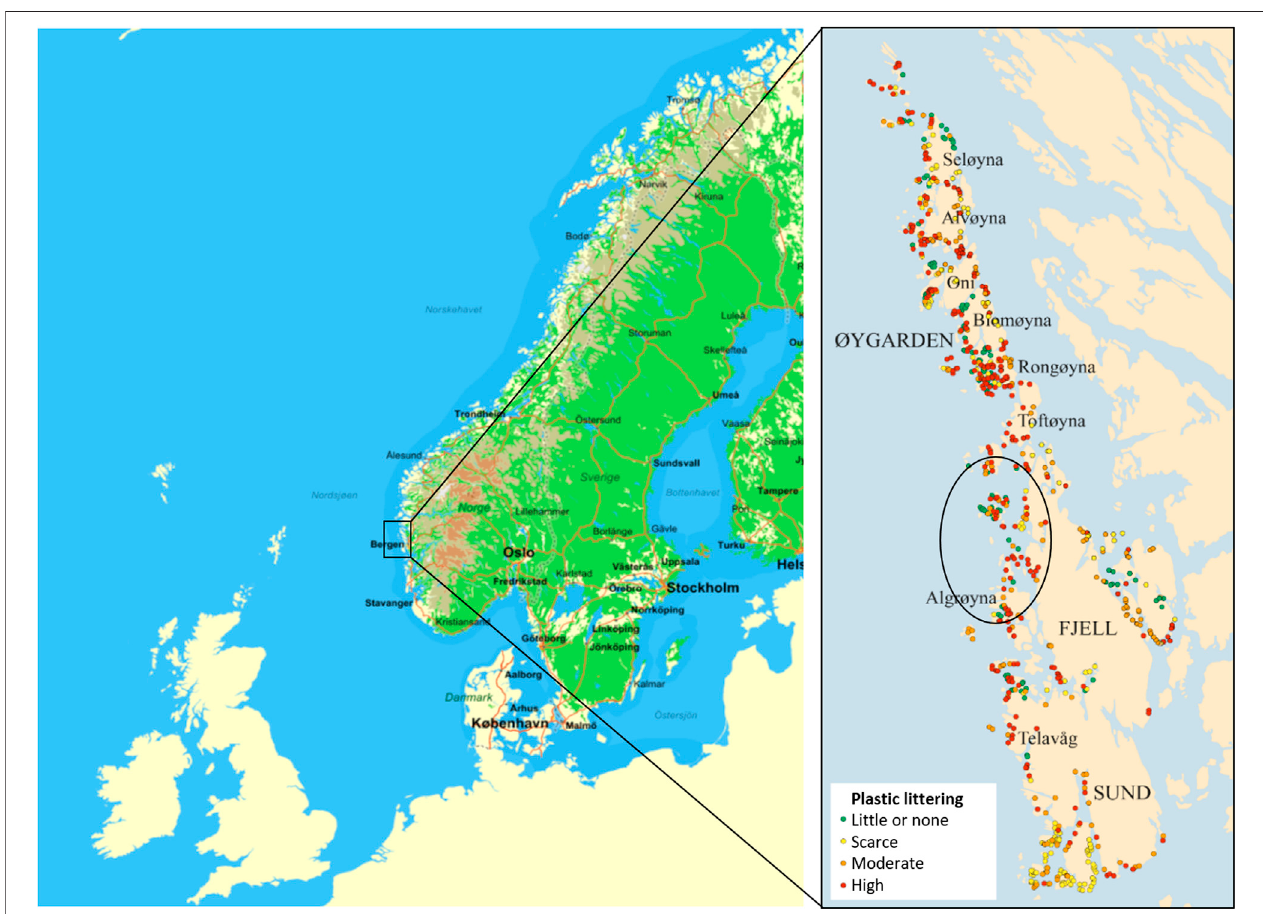
FIGURE 1 | Map of Norway with the Sotra Achipelago to the West, and the plastic exposed area (circled) where the samples were caught. Map of plastic littered bays from Bastesen et al. (2020).